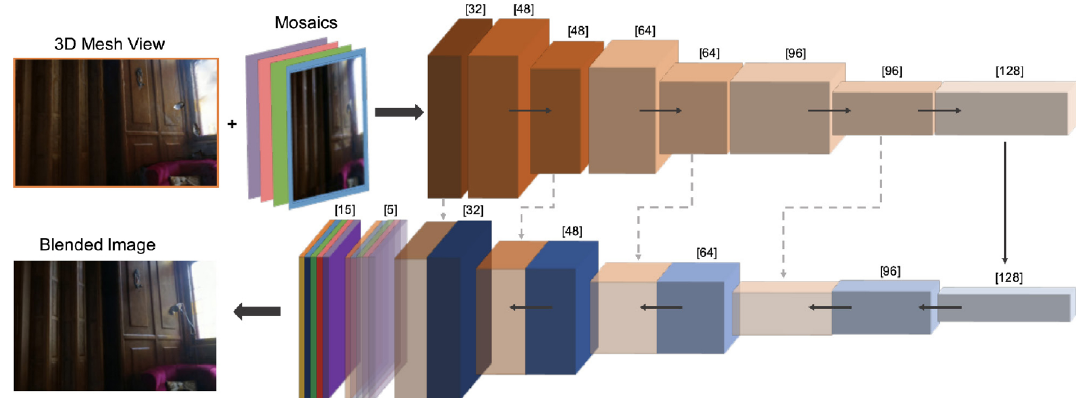
Fig. 3 The network architecture of DeepBlending for free-viewpoint image-based rendering. Reproduced with permission from Ref. [61], c (cid:2) Association for Computing Machinery 2018.